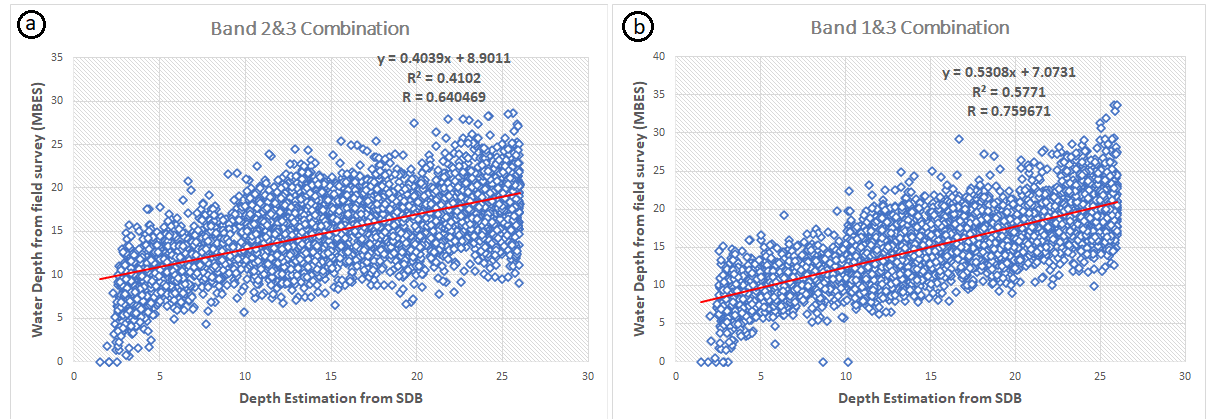
Figure 6 . Comparison from Each Combination with Field Data, (a) Band 2&3 Combination, (b) Band 1&3 Combination The correlation results are also presented in Table 3 along with RMSE results. The smaller the RMSE value, the better the results From Table 3, it can be seen that RMSE from Band 1&3 combination gives smaller value than Band 2&3 combination.